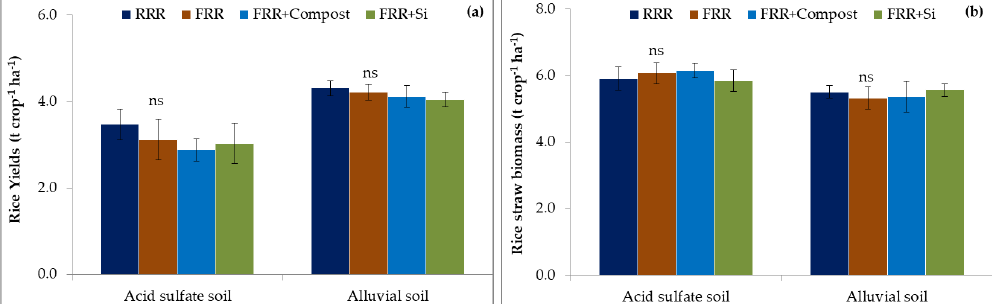
Figure 6. Rice yields and straw biomass (mean ± standard error, n = 4) among treatments in acid sulfate soil ( a ) and alluvial soil ( b ) in Ben Tre province and Kien Giang province, Vietnam, respectively. There were no differences in rice yield and straw biomass between treatments in both soil types. ns, not significant. Rice yield and straw biomass in acid sulfate soil have been reported to RRR, FRR and FRR + Compost treatments in study by Phuong et al. [47]. RRR, triple–rice system; FRR, fallow and double–rice; FRR + Compost, fallow and double–rice with 3 Mg ha − 1 sugarcane filter cake compost; FRR + Si, fallow and double–rice with 100 kg ha − 1 silicate